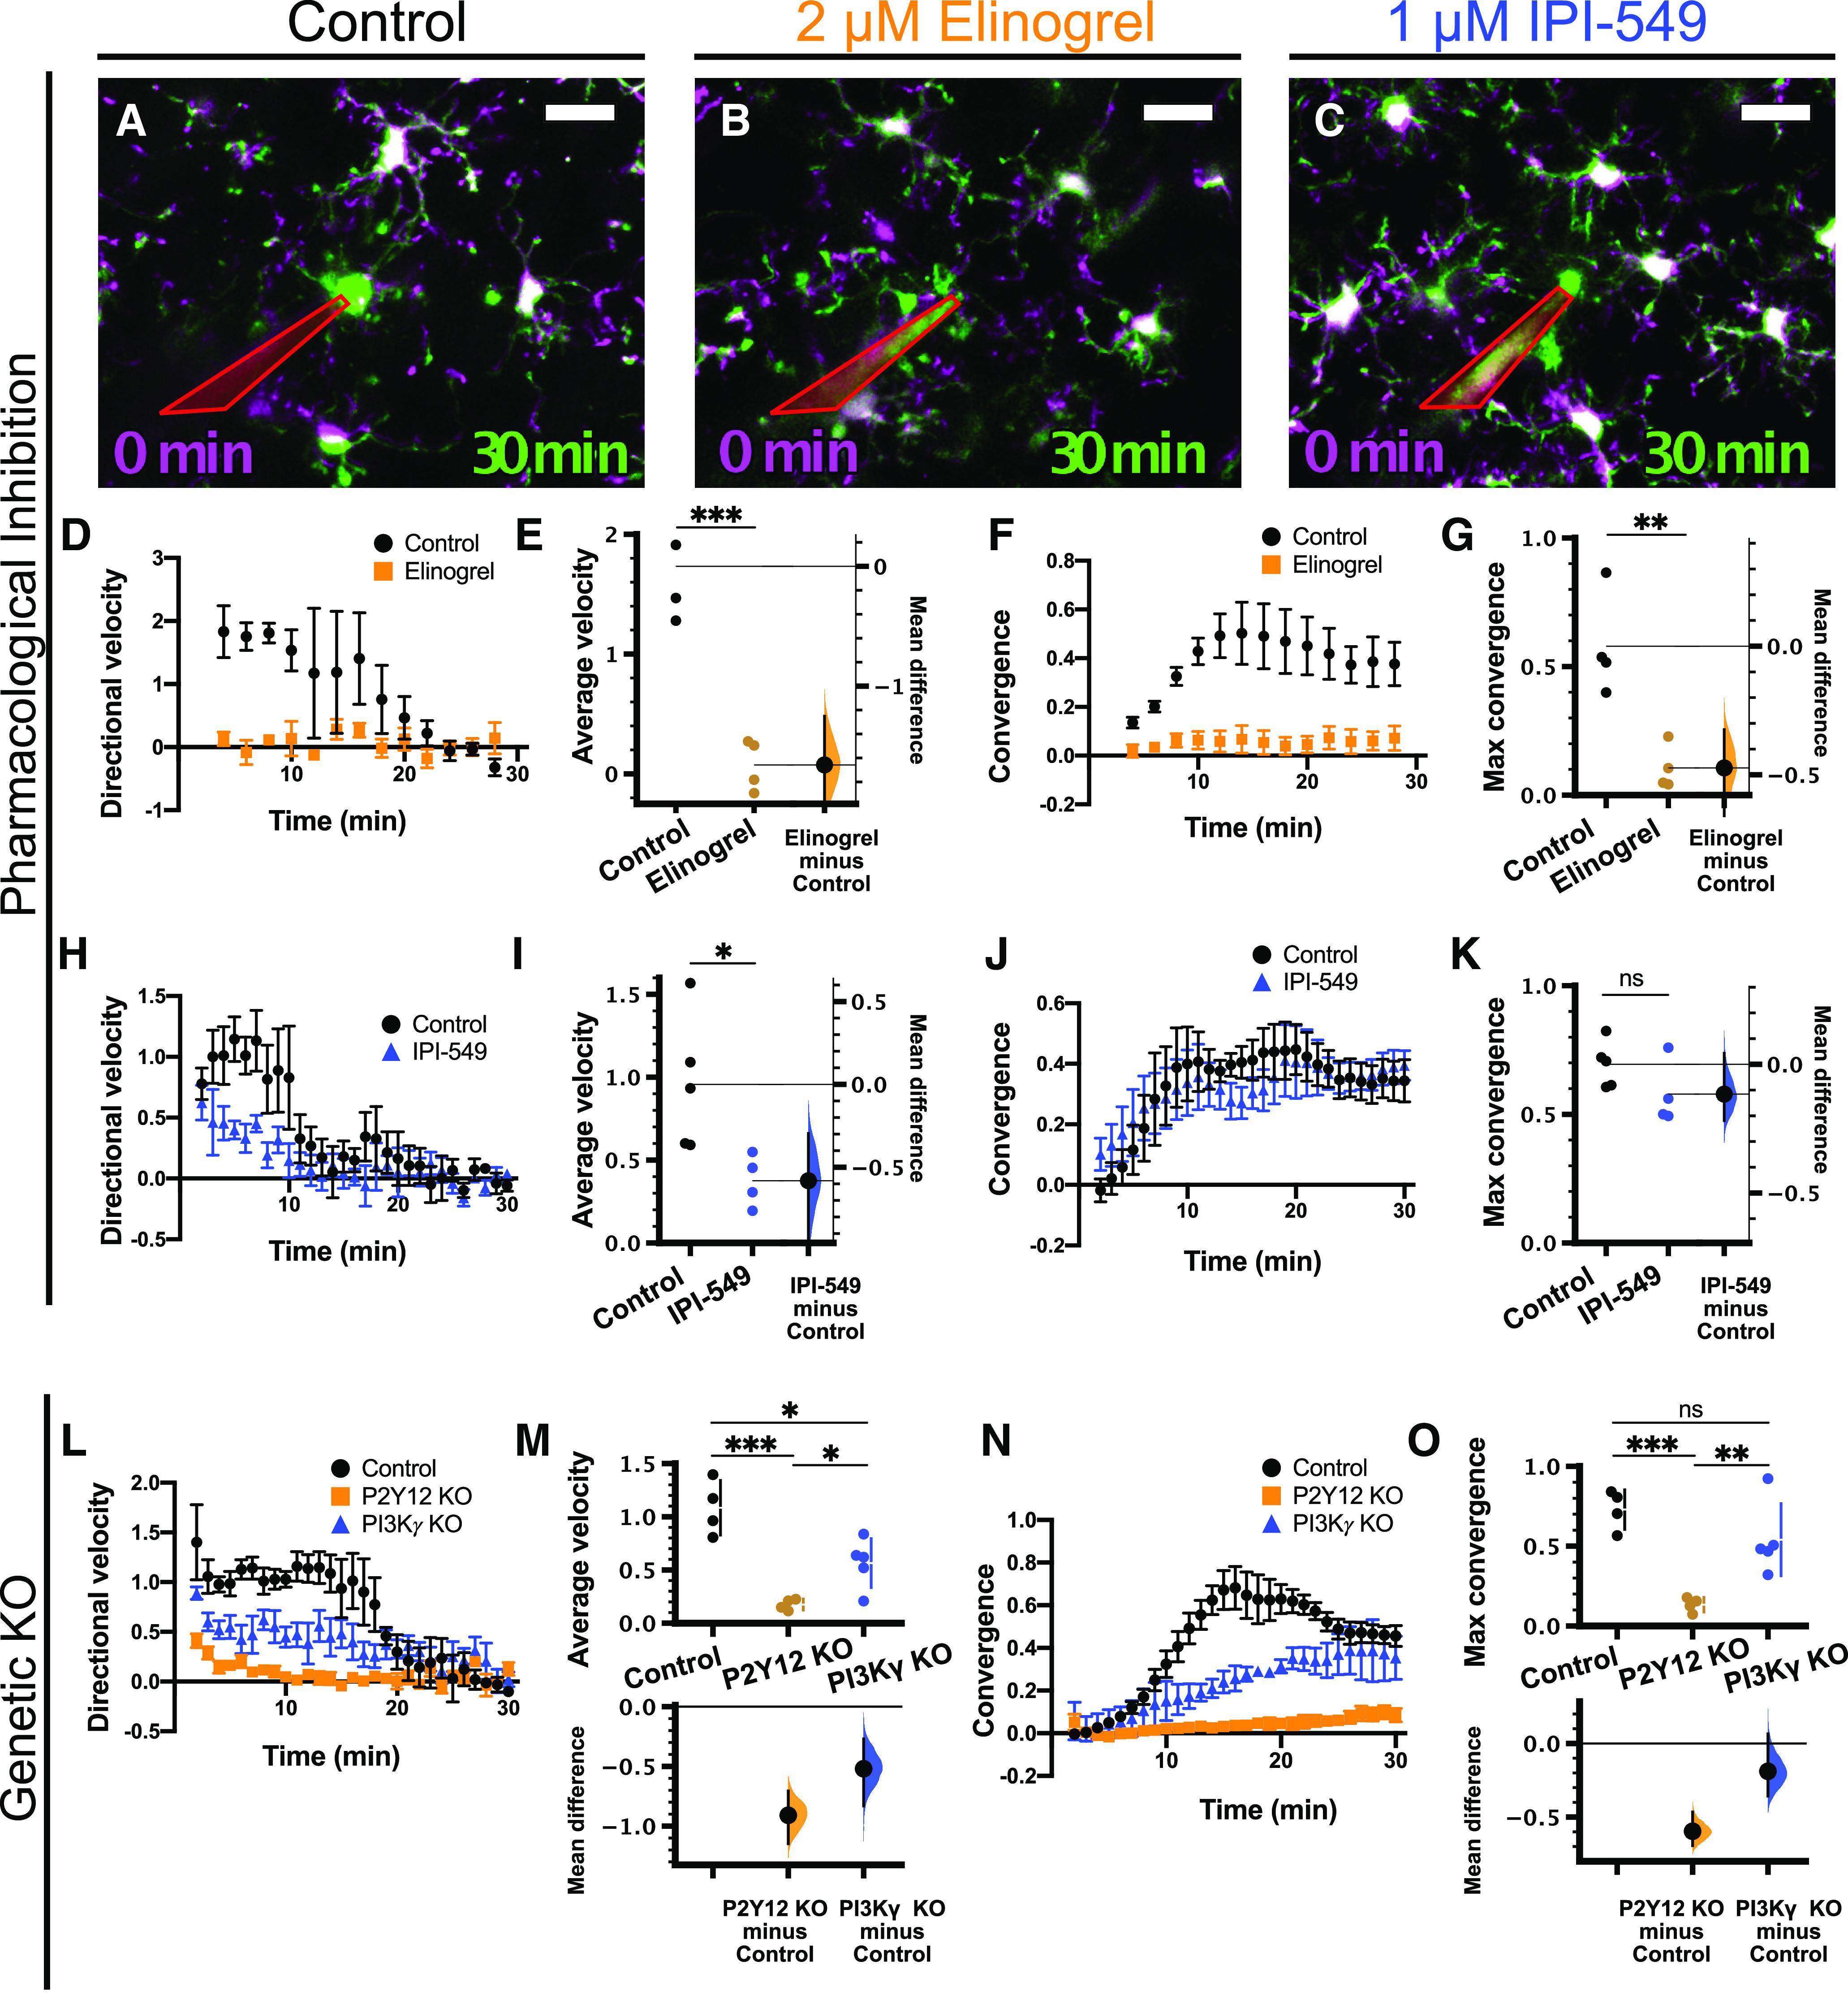
PI3Kγ is not required for the microglial response to focal ATP release in acute cortical slices. Overlays of representative responses from control (A), 2 μm elinogrel-treated (P2Y12 inhibitor; B), and 1 μm IPI-549-treated (PI3Kγ inhibitor; C) slices at the time points indicated. Images at later time points (green) are overlaid with initial images (t = 0 min, magenta). In A–C, the pipette is outlined in red. D–G, Effects of 2 μm elinogrel on the microglial response to focal ATP release [n (slices) = 4 control, 4 elinogrel; from 4 animals total]. D, Time course of directional velocity, with one frame acquired every 2 min. Quantification begins at t = 4 min (two frames after puff) to avoid artifacts from the dye included in the pipette solution which leaks into the imaging field at earlier time points. E, Elinogrel completely blocks the directional response [comparisons made on average velocity calculated in the interval of 4–10 min after ATP presentation; unpaired t test, p = 0.0005; mean difference is −1.66 (95%CI −2.11, −1.25)]. F, Time course of convergence. G, Elinogrel reduces the maximum convergence [unpaired t test, p = 0.0048; unpaired mean difference is −0.473 (95%CI −0.708, −0.325)]. H–K, Effects of 1 μm IPI-549 on the microglial response to focal ATP release [n (slices) = 5 control, 4 IPI-549; from 5 animals total]. H, Time course of directional velocity, with one frame acquired every minute. Quantification begins at t = 2 min (two frames after puff). I, IPI-549 partially reduces the directional response [comparisons made on average velocity calculated in the interval of 2–10 min after ATP puff; two-tailed t test p = 0.031; mean difference is −0.581 (95%CI −0.995, −0.296)]. J, Time course of convergence. K, IPI-549 does not affect the maximum convergence [two-tailed t test, p = 0.15; mean difference is −0.116 (95%CI −0.219, 0.0431)]. L–O, Effects of P2Y12 KO (orange) or PI3Kγ KO (blue) on microglial response to focal ATP release in slices [n (animals) = 4 control; 4 P2Y12 KO; 5 PI3Kγ KO]. L, Time course of directional velocity with one frame acquired every 1 min. M, P2Y12 KO and PI3Kγ KO reduce the directional velocity compared with control [comparisons made on average velocity calculated in the interval of 2–10 min after ATP presentation; one-way ANOVA p = 0.0003; Tukey’s test: control vs P2Y12 KO p = 0.0002; control vs PI3Kγ KO p = 0.0089; P2Y12 KO vs PI3Kγ KO p = 0.042; mean differences vs controls: P2Y12 KO −0.909 (95%CI −1.15, −0.706); PI3Kγ KO −0.52 (95%CI −0.832, −0.27)], although the magnitude of the effect is larger in P2Y12 KOs. N, Time course of convergence. O, P2Y12 KO decreases maximum convergence, while PI3Kγ KO does not affect maximum convergence [one-way ANOVA p = 0.0011; Tukey’s test: control vs P2Y12 KO p = 0.0010; control vs PI3Kγ KO p = 0.23; P2Y12 KO vs PI3Kγ KO p = 0.0090; mean differences vs controls: P2Y12 KO −0.596 (95%CI −0.693, −0.465); PI3Kγ KO −0.189 (95%CI −0.358, 0.0652)]; ns, non-significant; *p < 0.05, **p < 0.01, ***p < 0.001. Data presented as mean ± SEM. Scale bar: 20 μm. Additional data on the effects of inhibition of actin polymerization or activation of AC on directed microglial motility are presented in Extended Data Figures 4-1, 4-2, respectively.